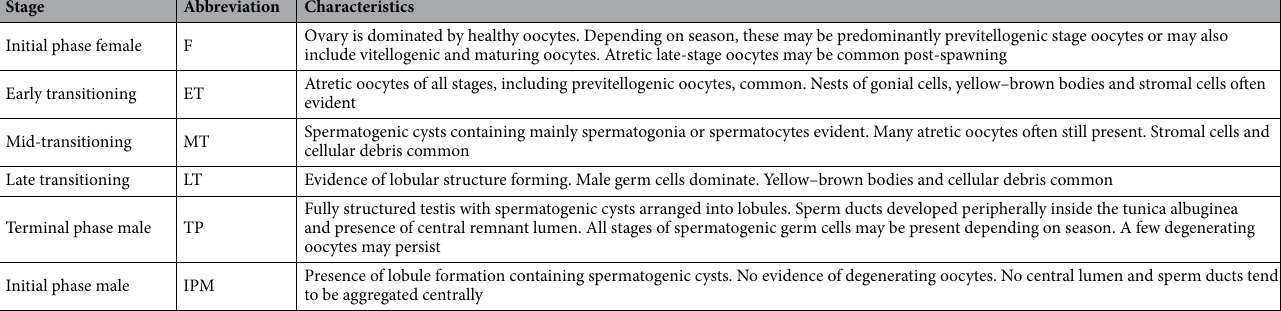
Table 1. Histological stages of gonadal sex change in New Zealand spotty